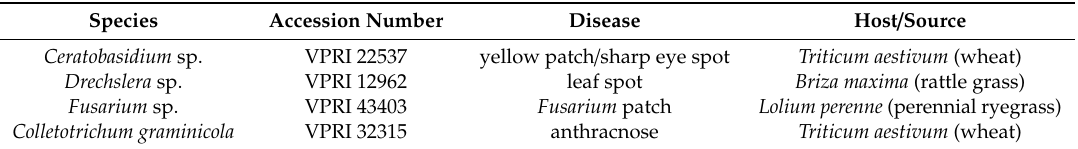
Table 3. Summary of pathogens selected for this study.